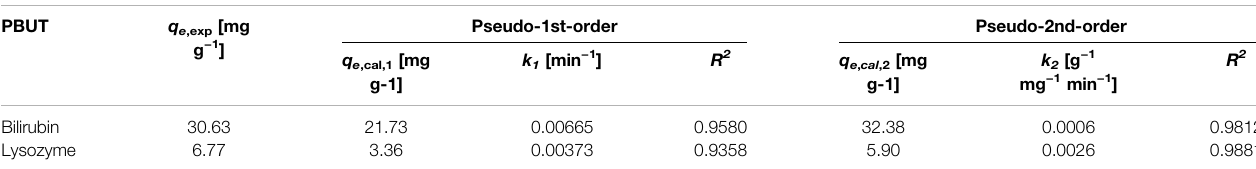
TABLE 3 | Adsorption kinetic parameters of HCP(St-DVB-VP) towards bilirubin and lysozyme. PBUT q e ,exp [mg g − 1 ]